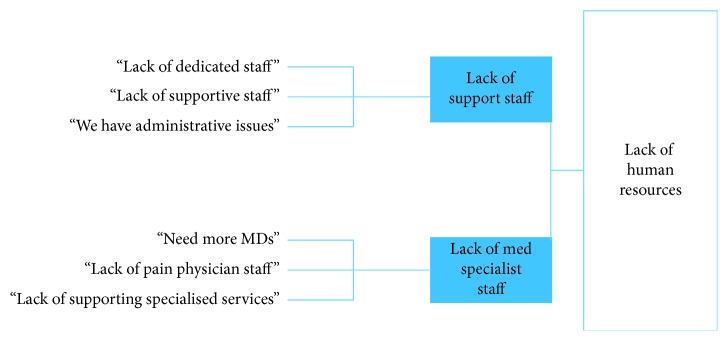
Example of dendrogram.